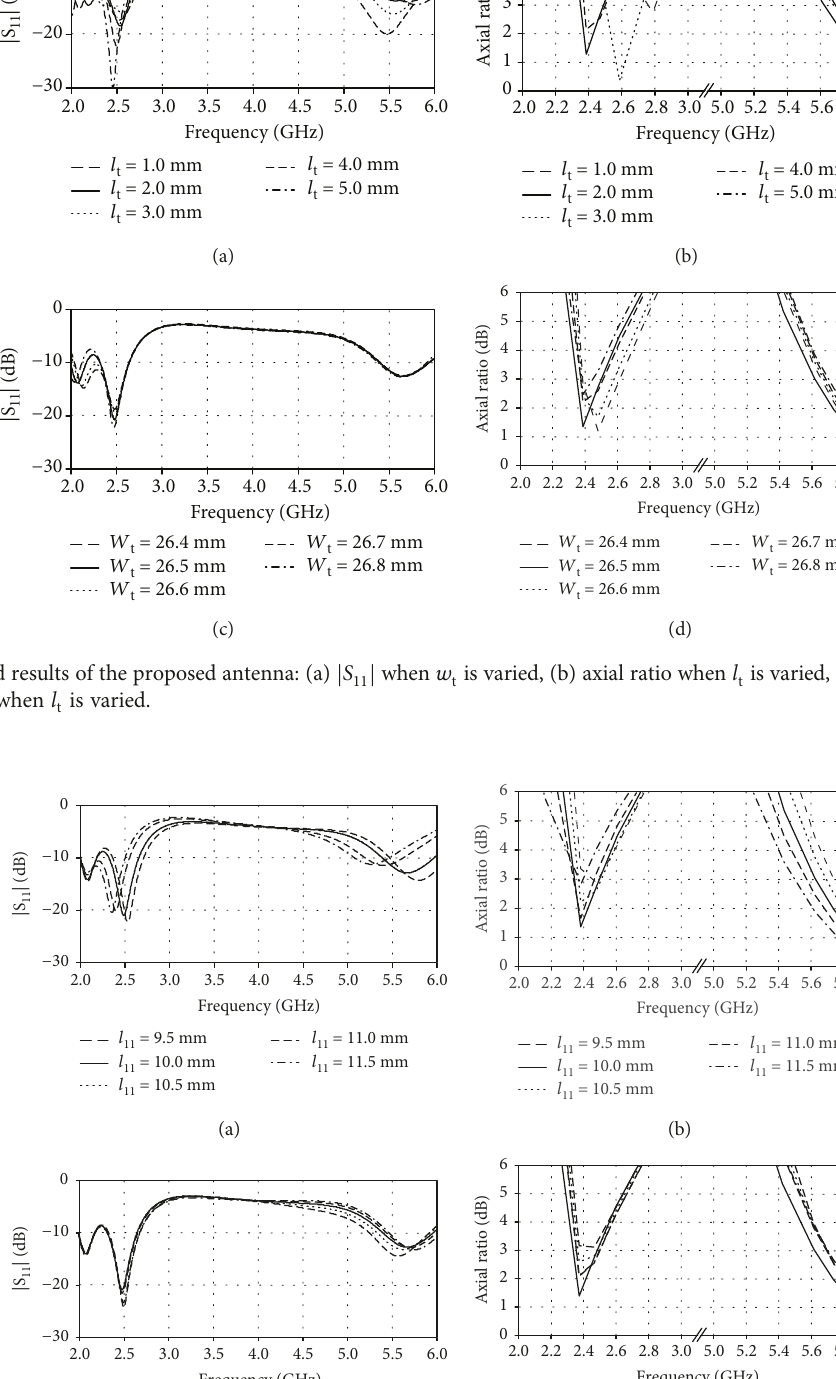
l l1 is varied, (c)